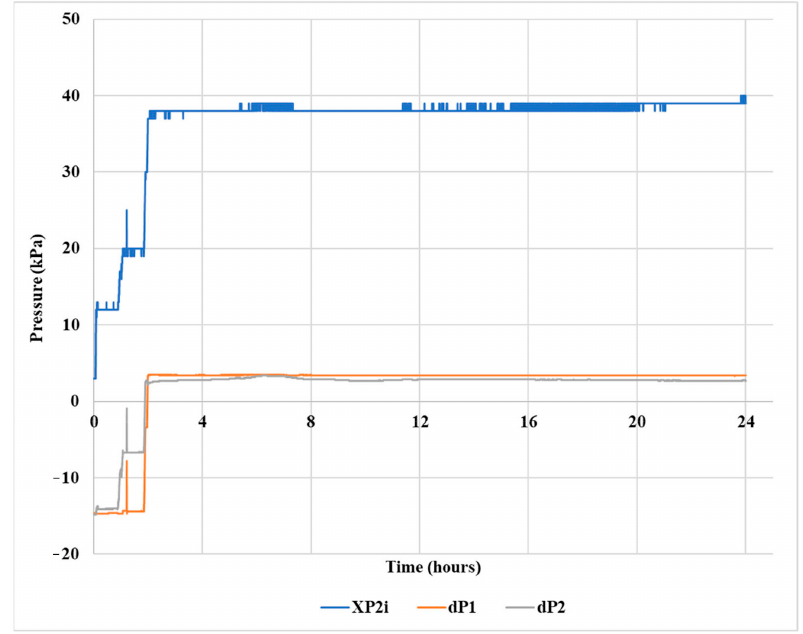
Figure 9. Recorded pressure during an experiment in a vertical fluid column using the bentonite gel pill. The bottom hole pressure is shown as the blue line. The differential pressures dP1 and dP2 are shown as the orange and gray lines, respectively.